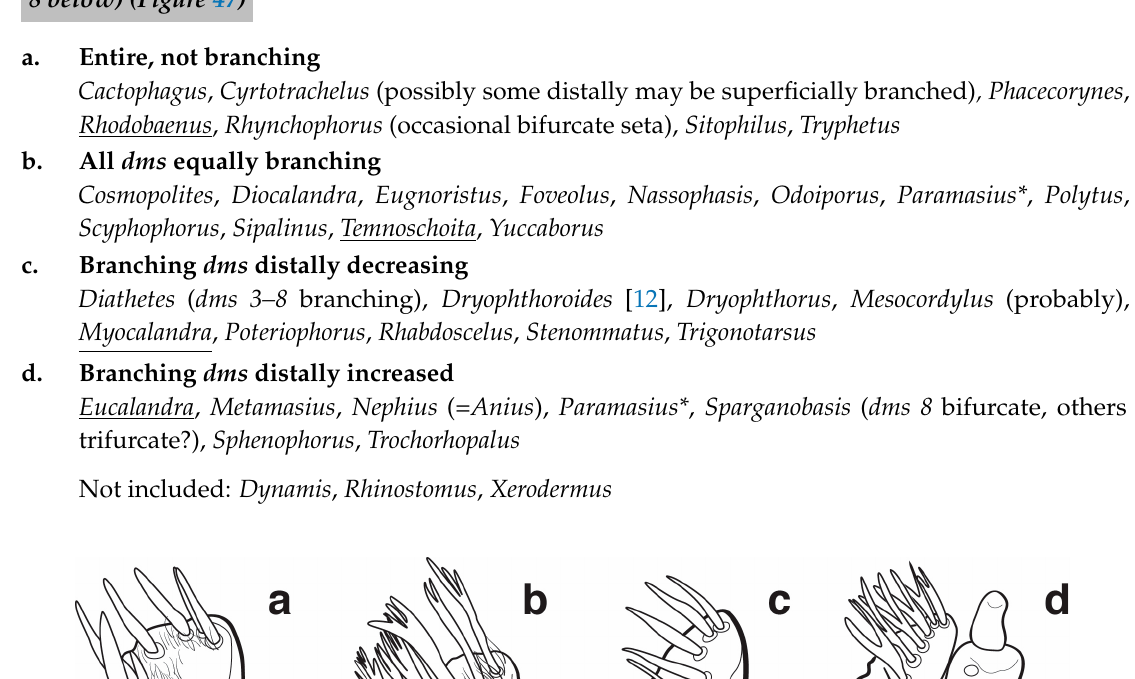
Figure 46. Hypopharynx, mala and maxillary palp, larva, dorsal view: ( a ) Cactophagus ; and ( b ) Cosmopolites .